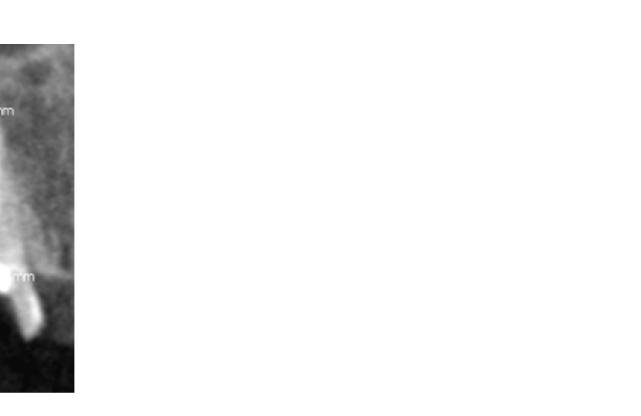
Figure 13. The CT scan of the tooth was used for the analysis of the root canals in the transverse plane, in the case of tooth 11.